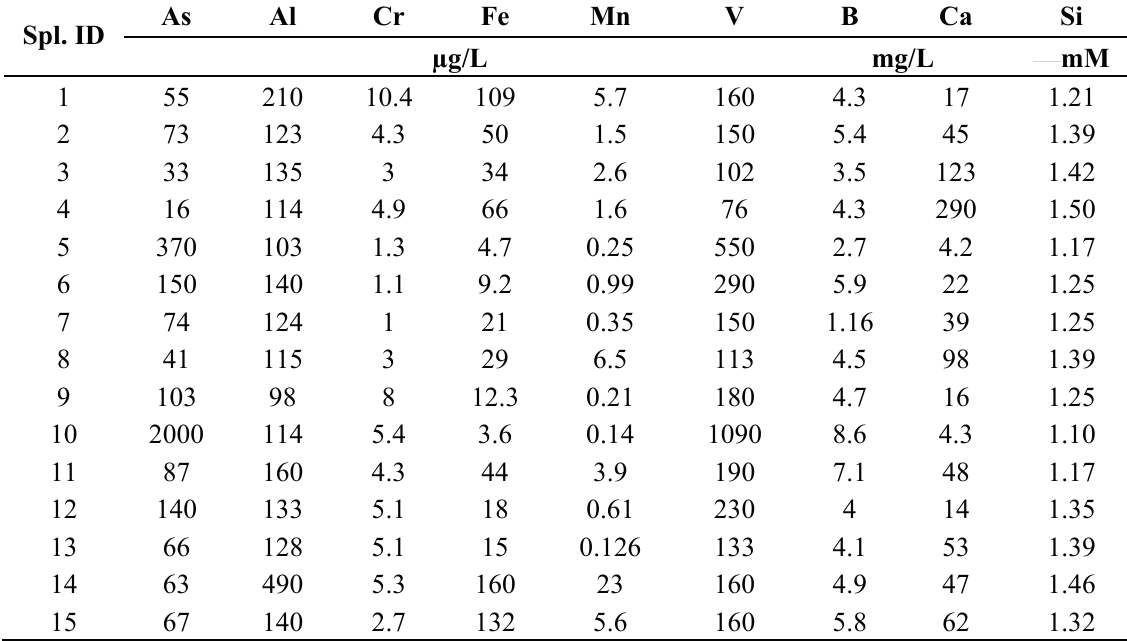
Table A4. Water quality data of 15 groundwater samples taken near Rafaela, Santa Fe province, Argentina (ICP-MS, UFZ, Leipzig, Germany). Spl.